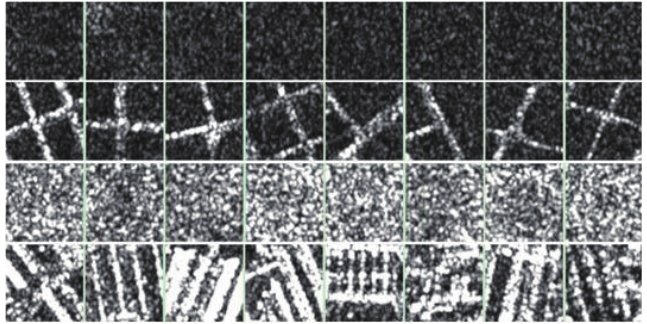
Eight samples from each class (from top to bottom: river, marsh, farmland and